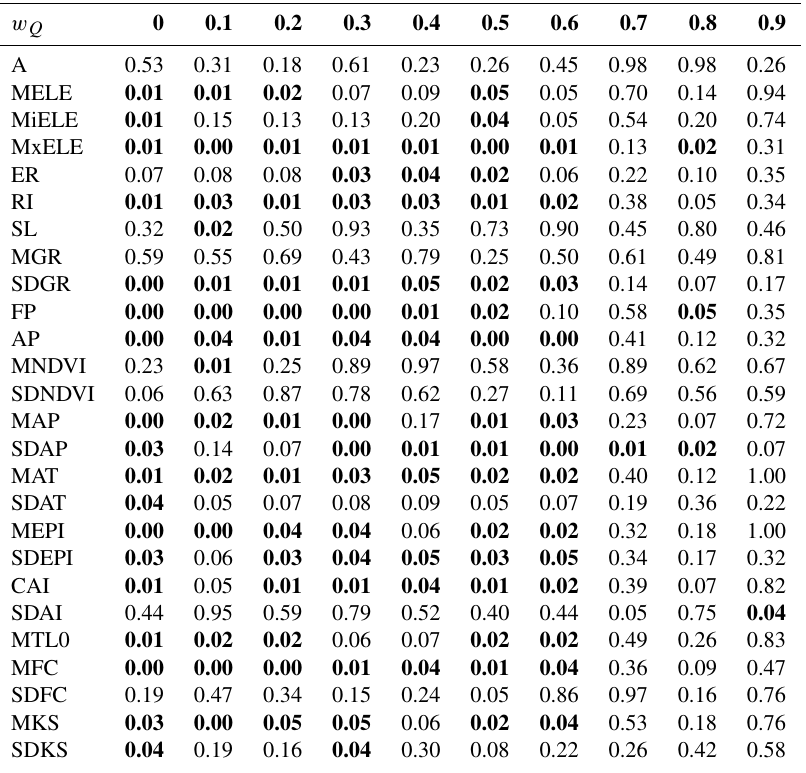
Table 7. Same as Table 6 but for the soil moisture model